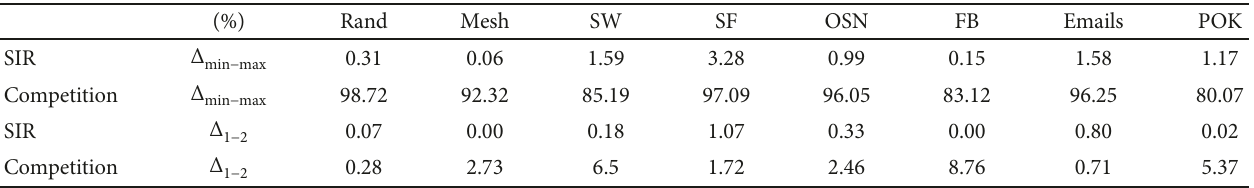
is the di ff erence (%) between the top 2 1 − 2